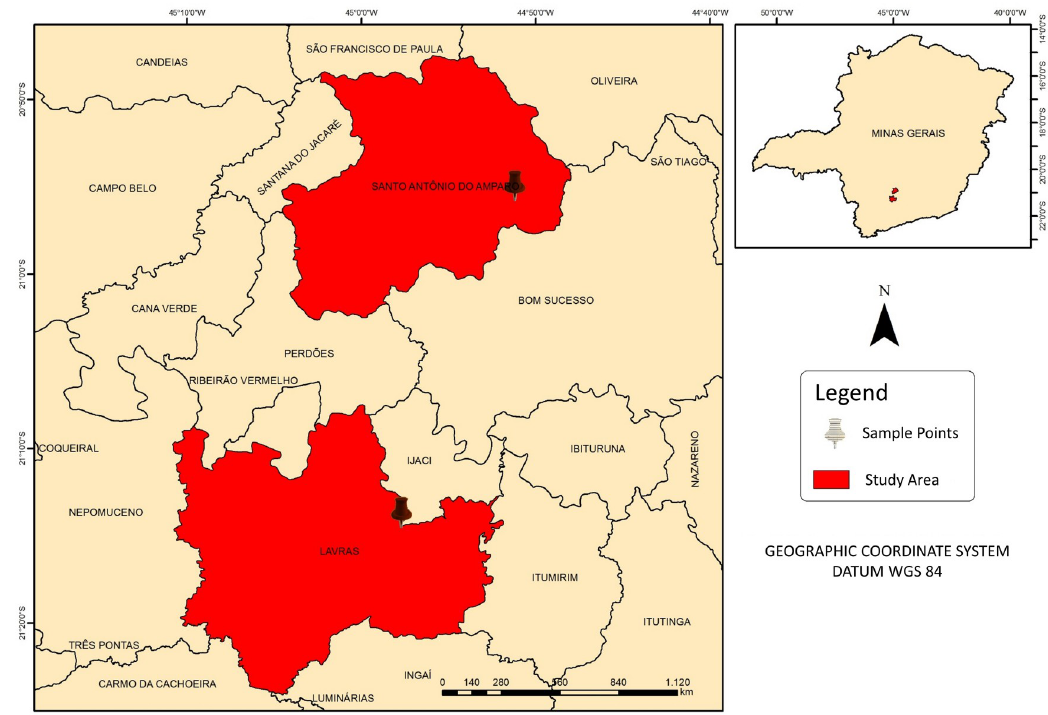
Fig 1. Study area.